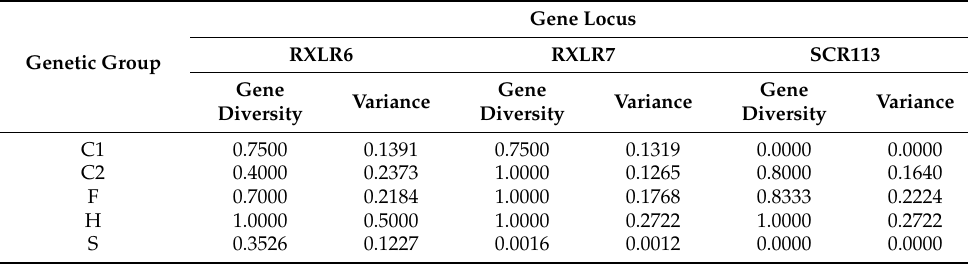
Table 7. Heterozygosity calculated for each genetic group of isolates of P. cactorum based on sequence data of three effector genes RXLR6, RXLR7 and